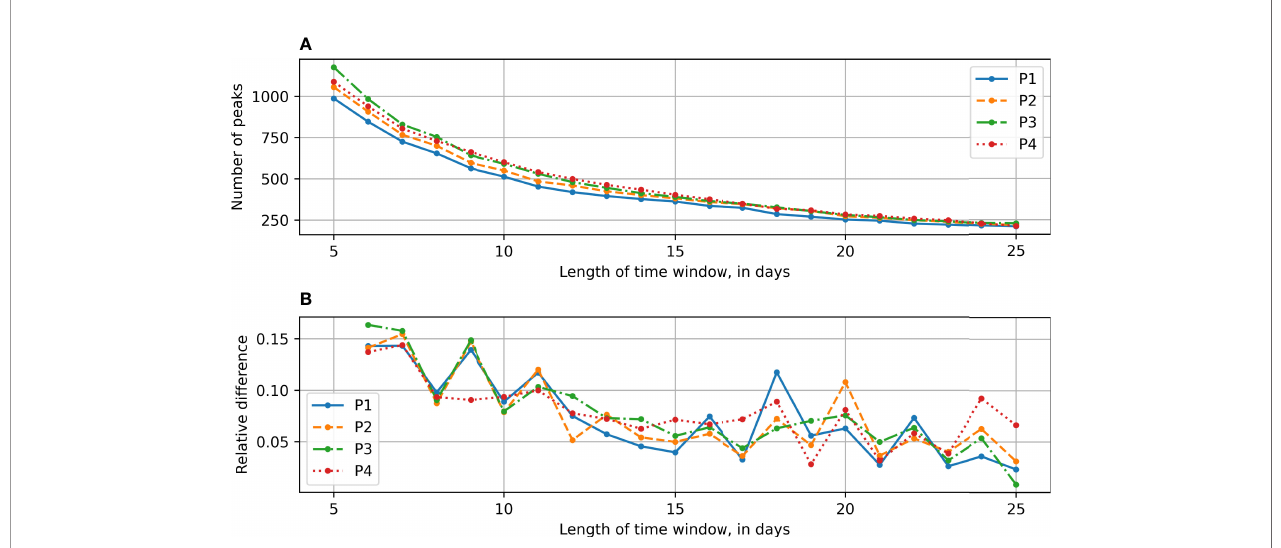
FIGURE 5 | Relation between the number of independent peaks and the length of the time window for the nodes at P1 to P4. (A) Number of identi fi ed peaks. (B) Relative difference in number of identi fi ed peaks to previous time window